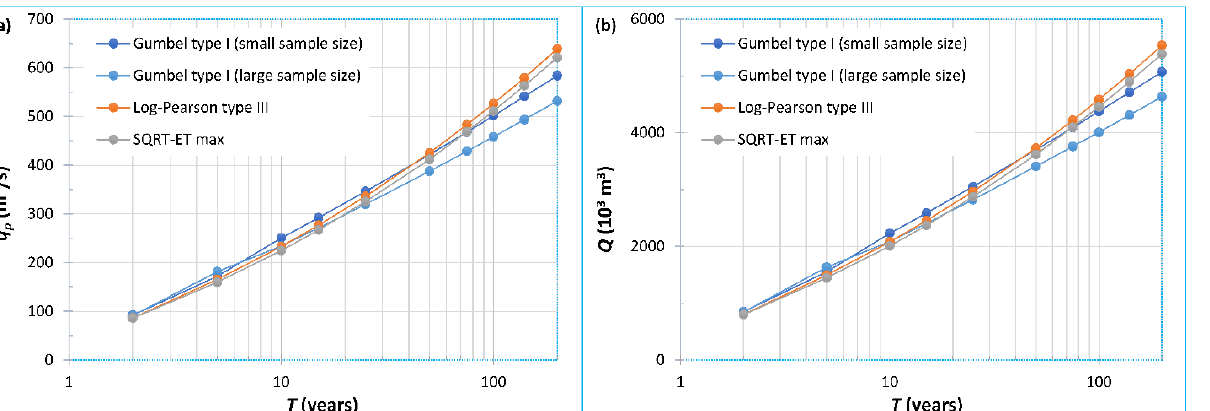
Figure 3. Thematic maps: ( a ) slope map, ( b ) land-cover map, ( c ) geological and soil map; ( d ) MUSLE factors.